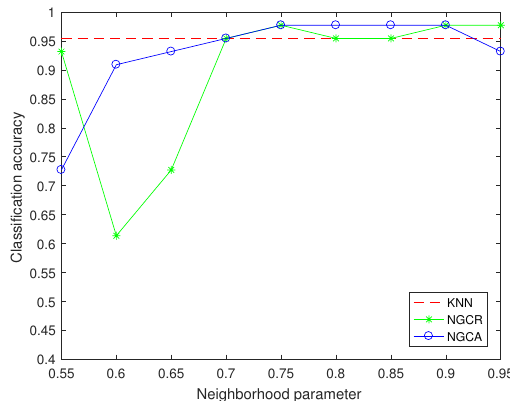
Figure 8. Classification accuracy for the wine